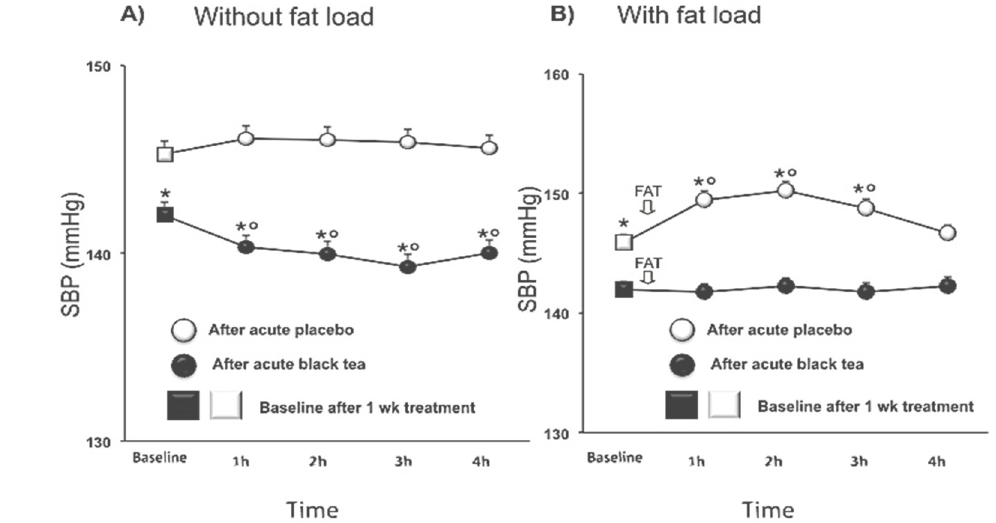
Figure 3. Effect of 1 week placebo (white) and black tea (black) administration on baseline (square) values (Panel A and B ) of systolic blood pressure and acute effects without and with fat load (Panel A and B ). Data are presented as LSmeans ± SE. In all panels vertical lines indicate SE and asterisks (*) indicate significant differences with respect the placebo phase (Panel A and B ) while circles (°) indicate significant differences from baseline values (Panel A and B ). Differences are considered significant when p <